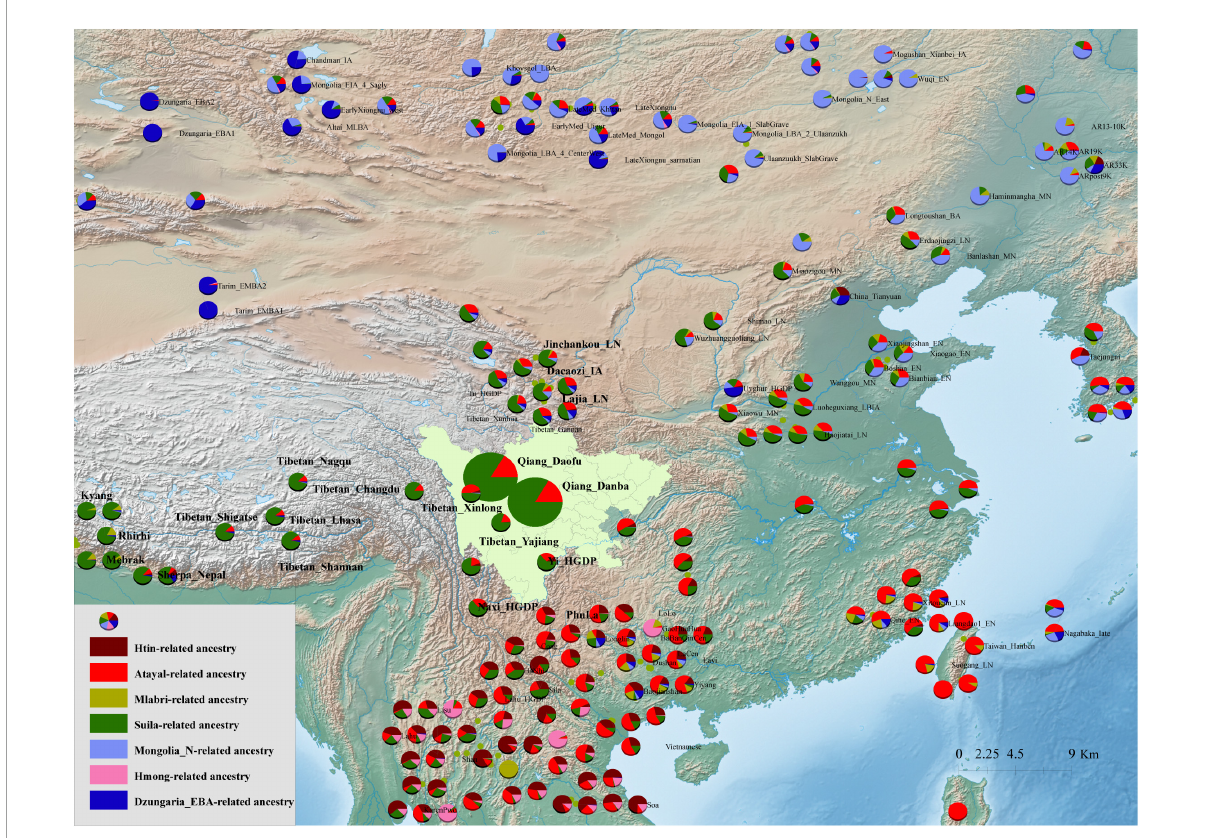
FIGURE5 Ancestry composition of 233 modern and ancient Eurasian populations based on the model-based ADMIXTURE model. We used the merged HO and Illumina datasets here. K equal to six has the least cross-validation error.